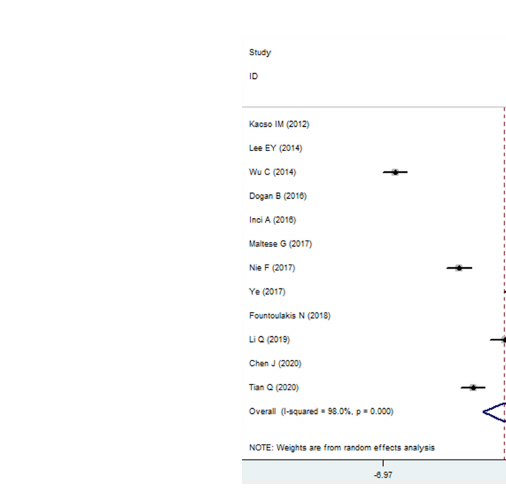
FIGURE 3 | Forest plots and funnel plots of sKlotho level in patients with early stage of diabetic nephropathy compared to diabetes without diabetic nephropathy. Diamond represents the pooled SMDs at 95% CI. SMD, standardized mean difference; CI, con fi dence